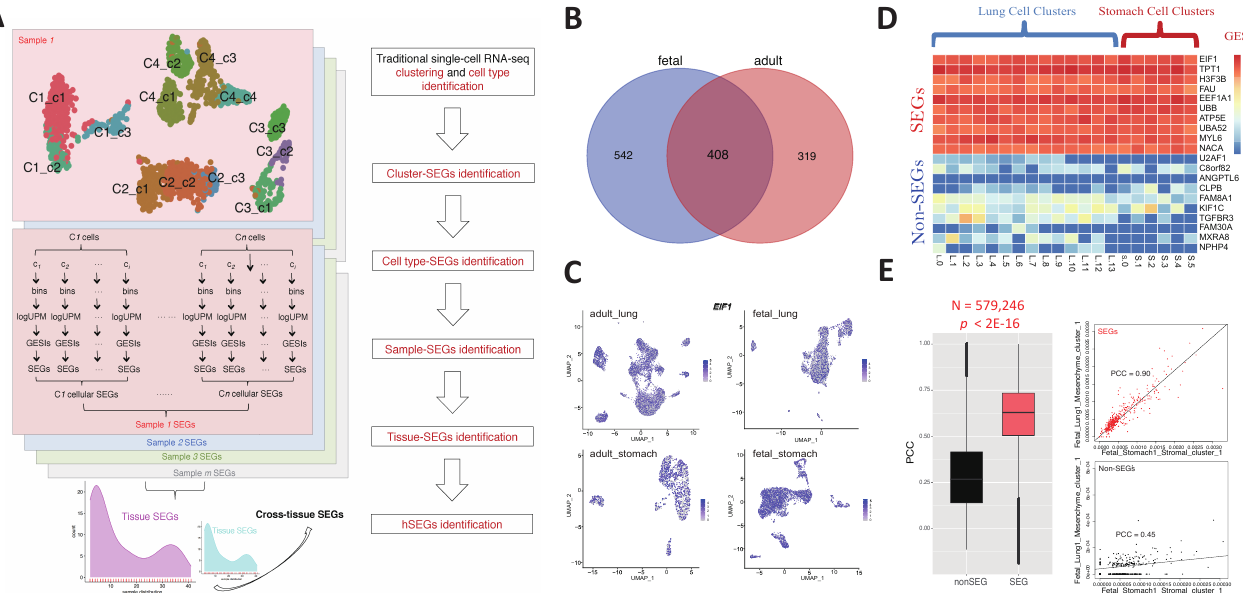
Figure 1. Identification of SEGs at single-cell level. ( A ) The pipeline for SEG identification. ( B ) 408 spatial-temporal SEGs were identified from both adult and fetal tissues. ( C ) Expression of a representative spatial-temporal SEG, EIF1 , in single-cell clusters of representative samples. One sample was selected randomly for each of the adult lung, adult stomach, fetal lung and fetal stomach tissues, respectively [25]. The single cells were clustered according to the gene expression profile, and shown as points in a two-dimension plane of Uniform Manifold Approximation and Projection (UMAP) [26]. The gene expression level was represented by the color shown in the scale bar. ( D ) GESI heatmap of representative SEGs and non-SEGs in cell clusters of representative samples. Ten spatial-temporal SEGs and ten non-SEGs were randomly selected. Two scRNA-seq samples were selected from the adult tissues randomly [25]. ( E ) Expression correlation of SEGs and non-SEGs between samples. All 408 SEGs and paired 408 non-SEGs randomly selected from the non-SEG gene set were used for the analysis and comparison. The Pearson Correlation Coefficients (PCCs) were calculated for SEGs and non-SEGs between each inter-sample cell-cluster pair, respectively, and there were 579,246 pairs in total. A Mann-Whitney U test was performed between the PCCs of SEGs and non-SEGs. The correlation of SEGs and non-SEGs between a representative cell-cluster pair was also